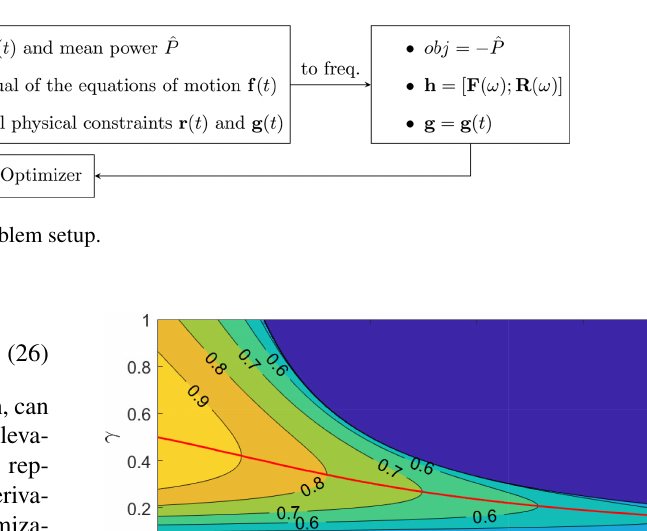
as a function of C D A = 0) P L ( C D A A t